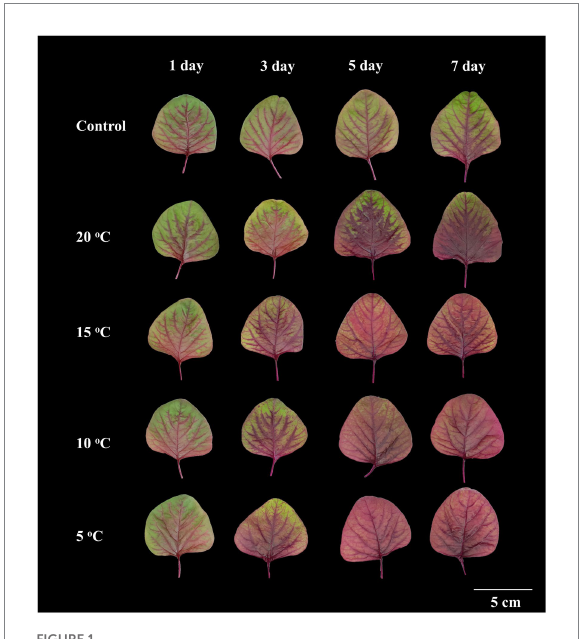
FIGURE 1 Morphology of amaranth leaves treated with different root-zone temperatures (RZT) for different periods (Experiment 1). The RZT at day/night-time: 5/5, 10/10, 15/15, and 20/20 ° C are indicated as: 5, 10, 15, and 20 °